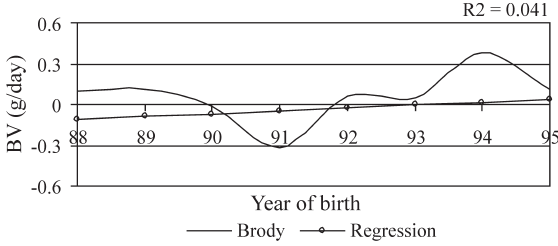
Figure 2 - Genetic trends of the breeding value (BV) and regression of the maturation rate by birth date of cows for the Brody model.